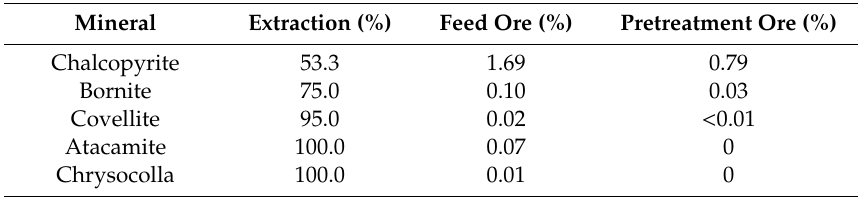
Table 6. Copper extraction (%) per mineralogical species and presence (%) in the feed ore and solid residue of pretreatment (test